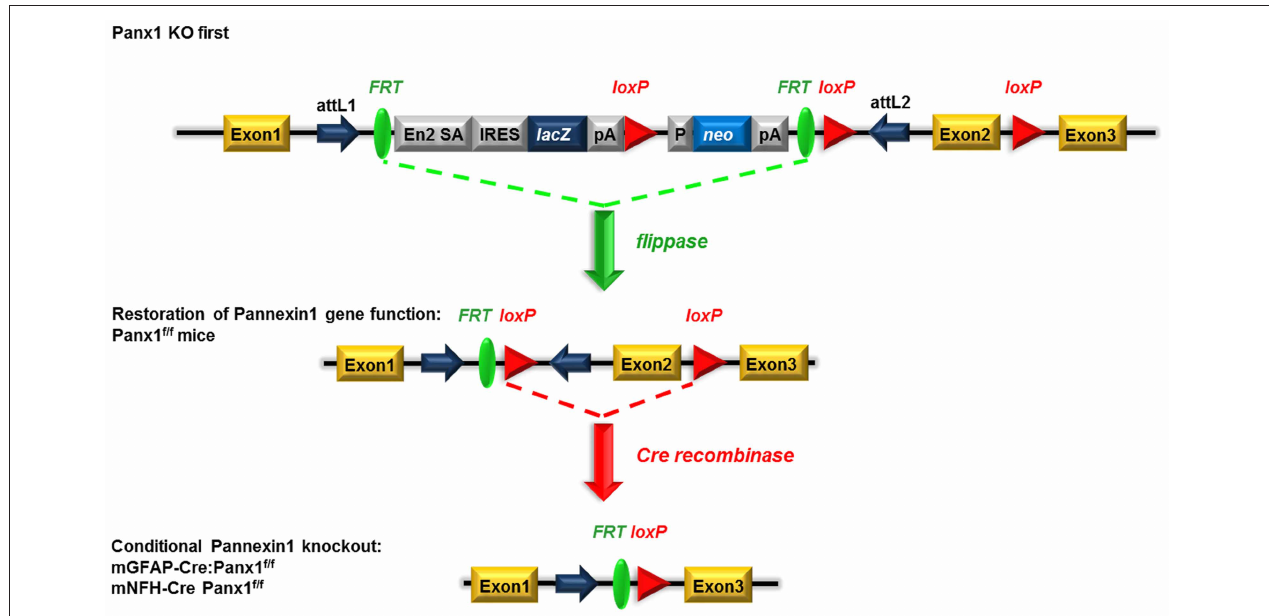
converting the “knockout-first” allele to a conditional allele (loxP sites flanking exon 2) and restoring Panx1 gene expression/activity. Upon removal of the floxed exon 2 with Cre recombinases, transcription of this Panx1 allele generates a frameshift mutation and premature stop codon, which triggers nonsense mediated decay of the transcript. Adapted from www.KOMP.org.